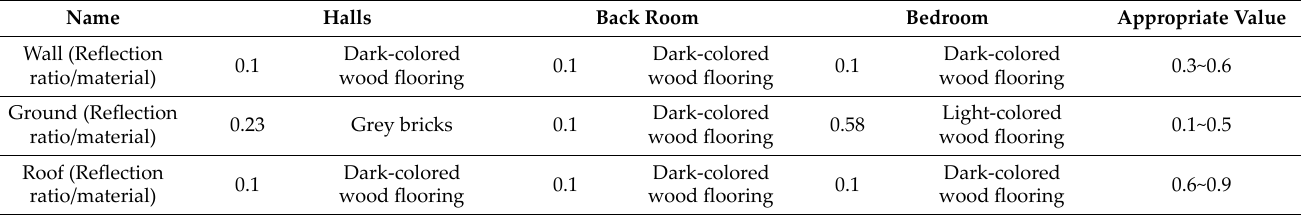
Table 4. Reflection ratio of interior